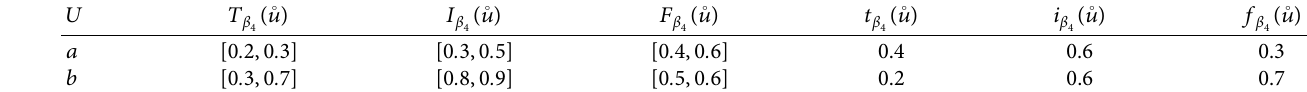
Table 15: Neutrosophic cubic set β